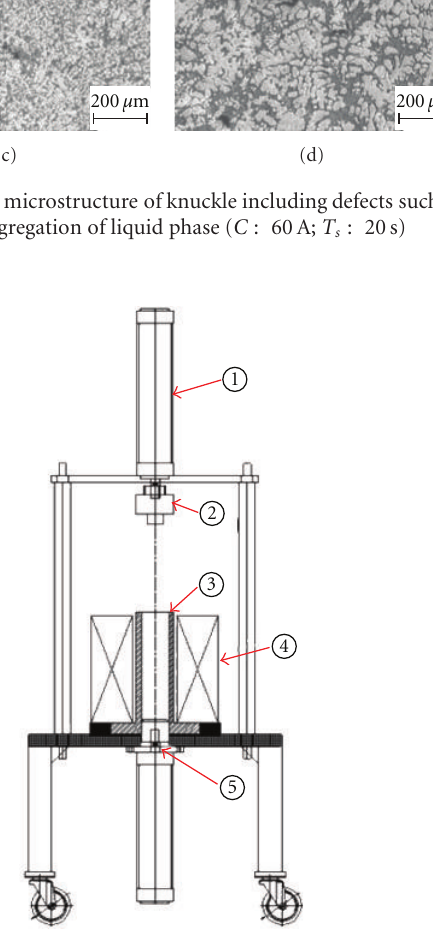
Figure 25: Schematic diagram of the vacuum casting system ((1) air cylinder, (2) Injection punch, (3) Sleeve, (4) Case, (5) Moving bottom punch).